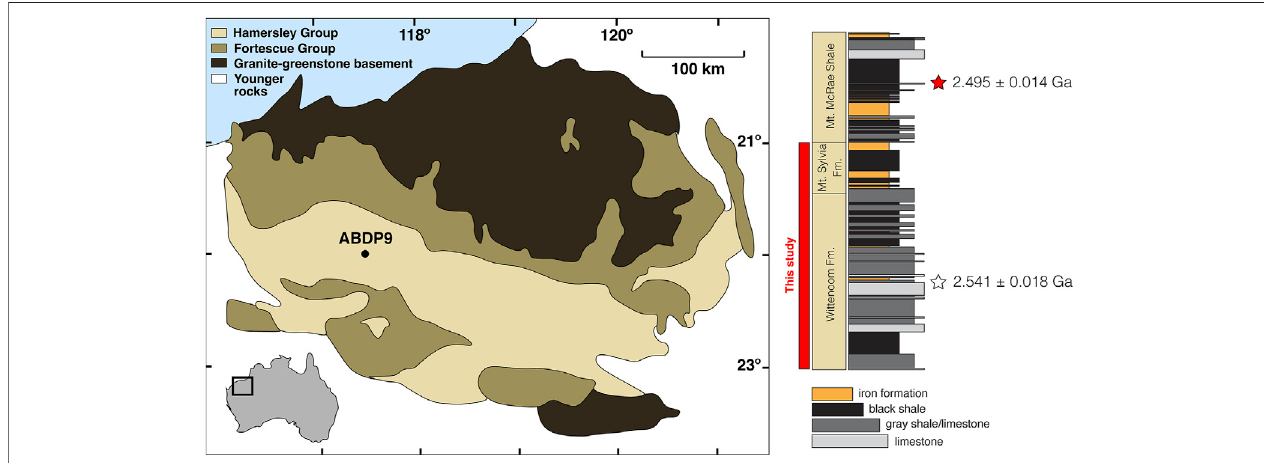
FIGURE1| GeologicalmapofthePilbaraCratonand ABDP9stratigraphy.Geologicalmapismodi fi edfromKurzweiletal.(2015)and stratigraphy ismodi fi edfrom Anbar et al. (2007) and Ostrander et al. (2020). Age constraints are from, in ascending order, Woodhead et al. (1998) and Kendall et al. (2015a).